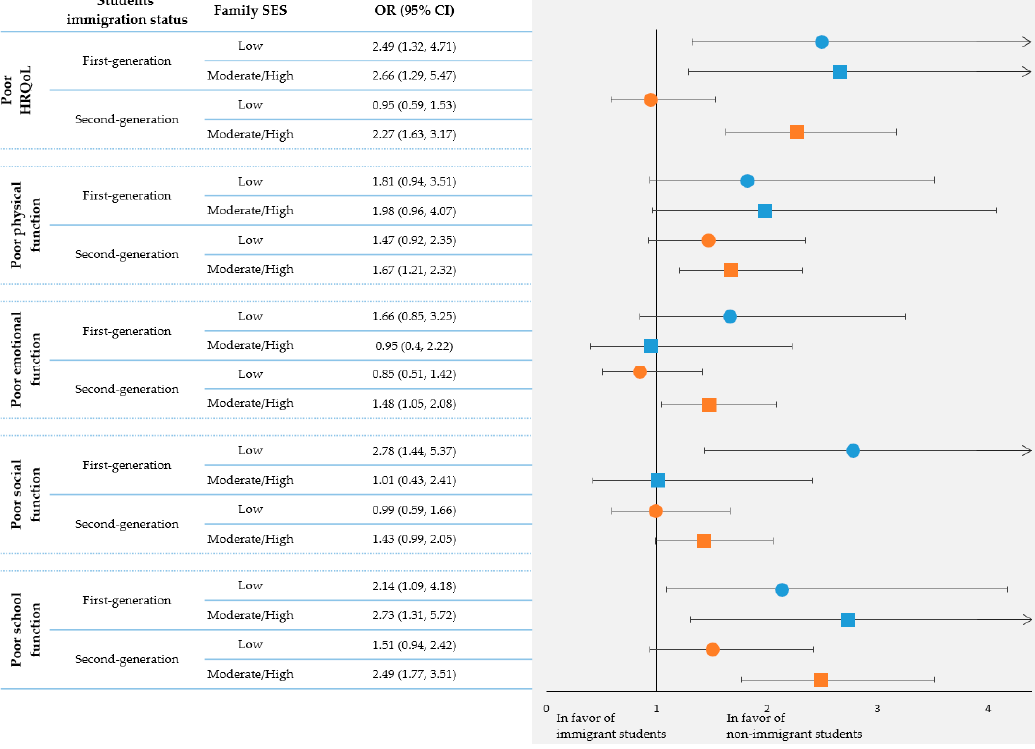
Figure 1. Logistic regression models with interaction analysis to present the association between immigration status and parent-perceived quality of life of students participating in the DIATROFI Program, according to family socioeconomic status. ORs and their corresponding 95%CI were obtained through logistic regression analysis including the interaction terms (students’ immigration status × SES) and using non-immigrant students as reference group. All models were adjusted for age and sex. Abbreviations: Health-related quality of life (HRQoL); socioeconomic status (SES); odds ratio (OR); 95% confidence interval (95%CI).